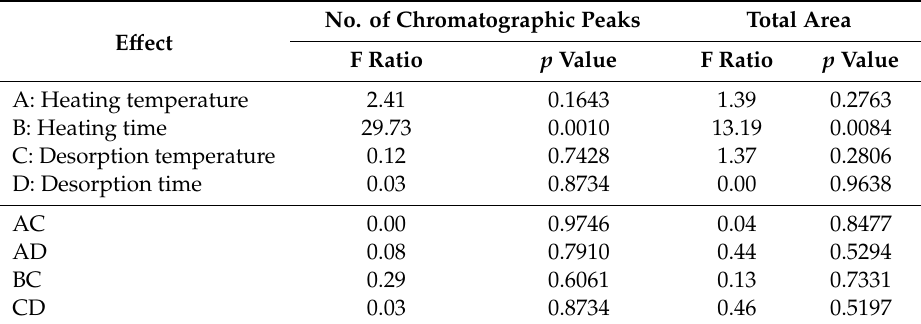
Table 3. Main e ff ects and interactions in the 2 4 factorial design for the number of chromatographic peaks and total